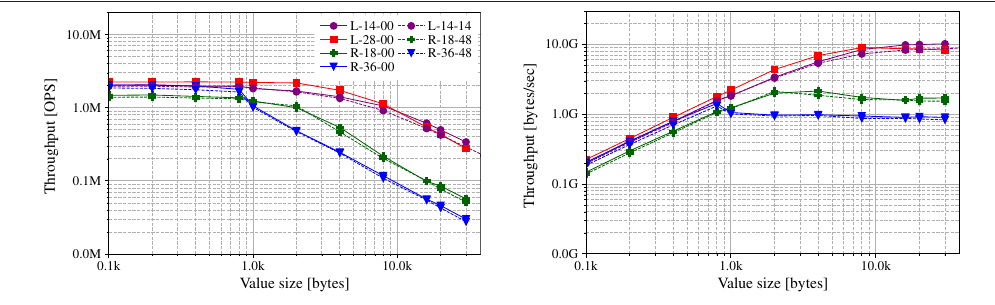
Figure 4. DAQDB throughput (operations per second and bytes per second) for di ff erent value